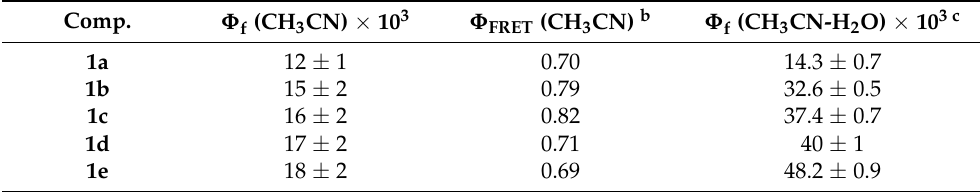
Table 1. Quantum yields of fluorescence Φ f a and efficiencies of FRET ( Φ FRET ) b . Comp.